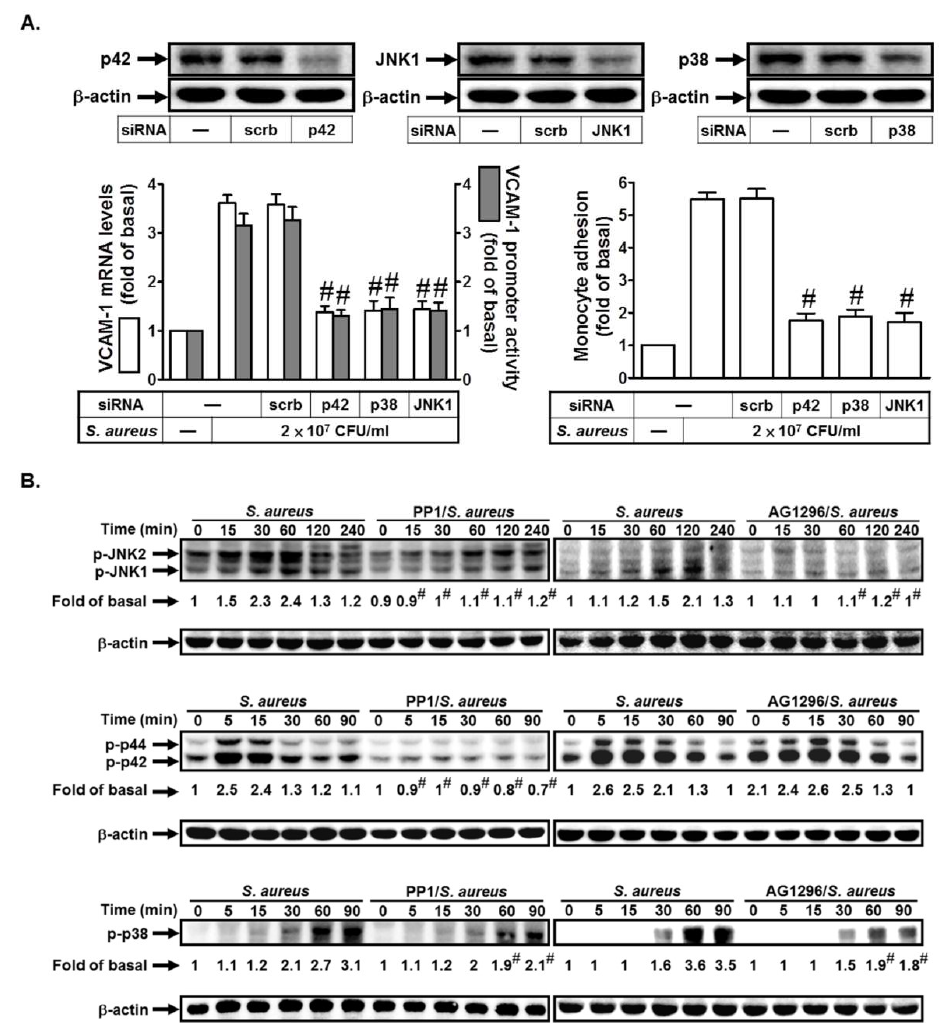
Figure 3. S. aureus induces VCAM-1 expression in HPAEpiCs via PDGFR. ( A ) Cells were transfected with scrambled, p42, p38, or JNK1 siRNA, and then incubated with S. aureus for 4 h, 6 h, or 24 h. The mRNA levels and promoter activity of VCAM-1 and the THP-1 cells adherence were measured. ( B ) Cells were pretreated without or with PP1 or AG1296 for 1 h, and then incubated with S. aureus for the indicated times. The expression of phospho-p38 MAPK, phospho-p42/p44 MAPK, and phospho-JNK1/2 were determined by Western blot. n = 3–4, # p < 0.01, as compared with the cells exposed to S. aureus + scrambled siRNA ( A ) or S. aureus alone ( B ).